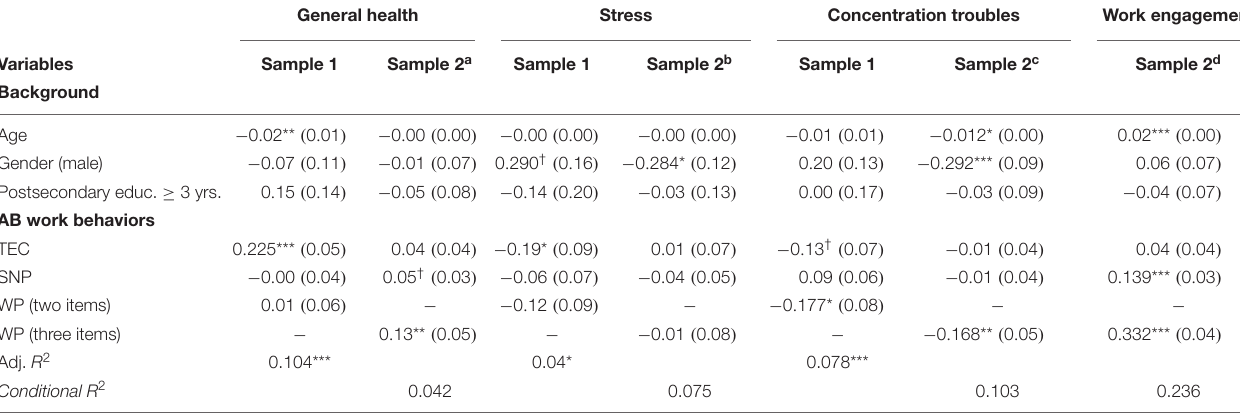
TABLE 5 | Regression analysis results, β values, and standard errors for Samples 1 and